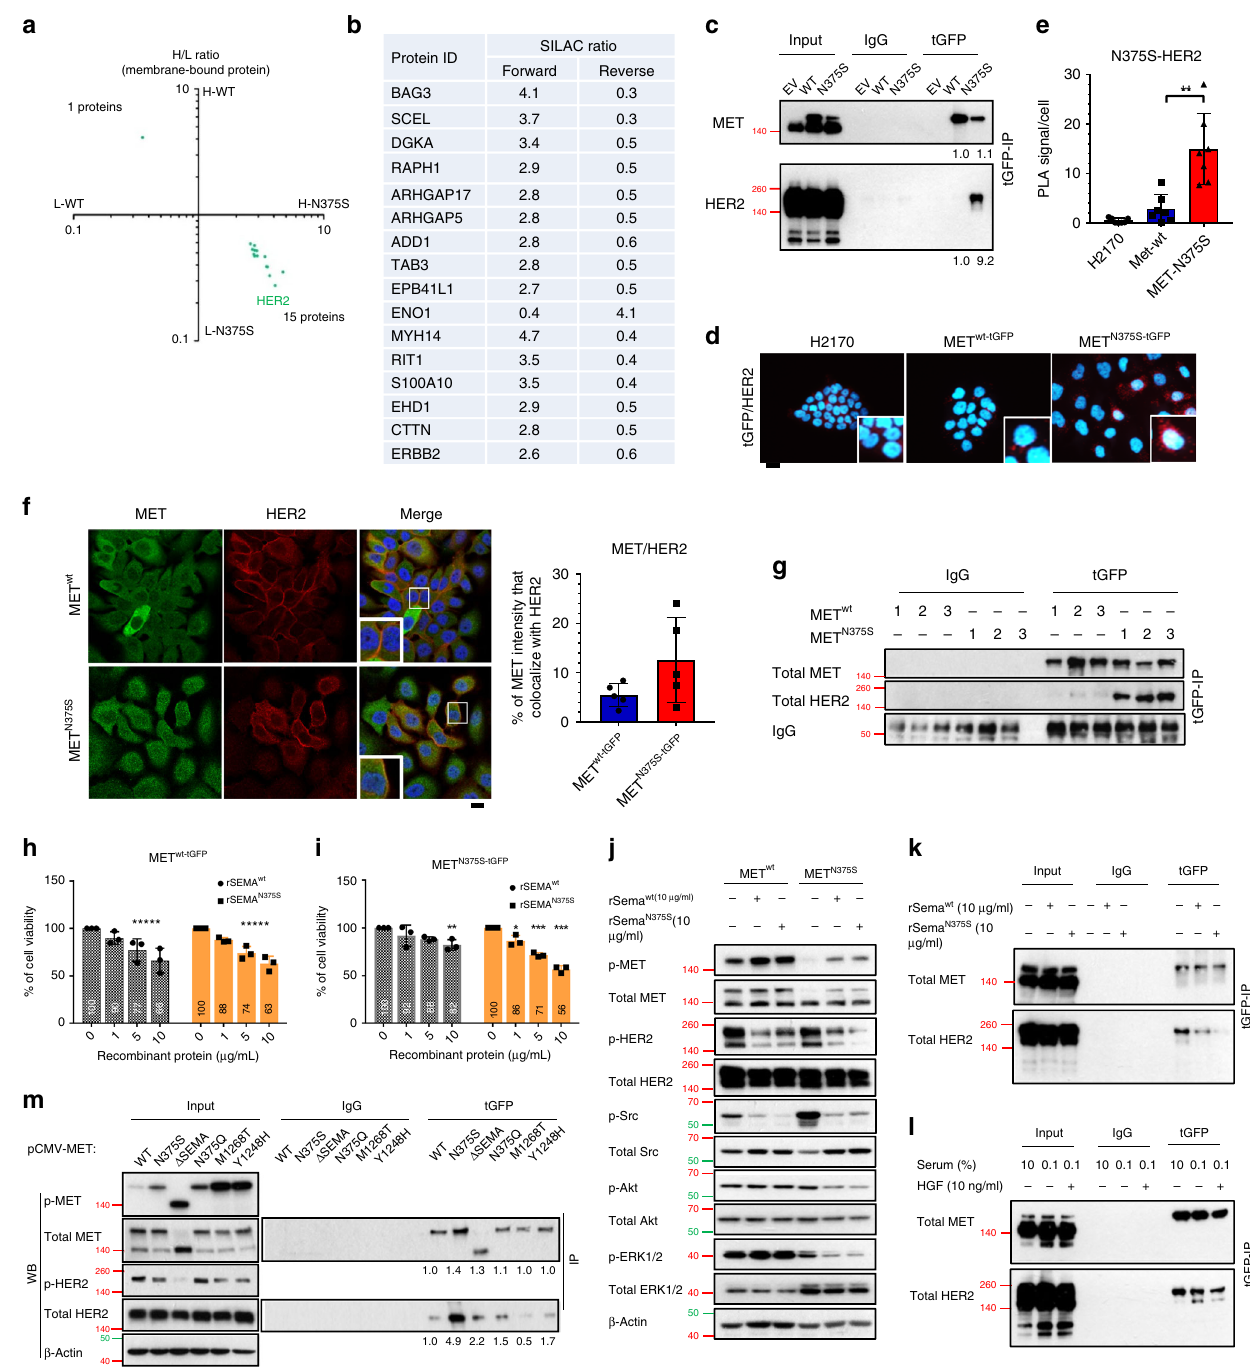
normalized SILAC ratio above 2.5 (in both “ forward ” and “ reverse ” experiments where the labels were switched) were selected for validation (Fig. 4a, b); and among these, only HER2 strongly co-immunoprecipitated with exogenous MET N375S (Fig. 4c; Supplementary Fig. 5A). This preferential interaction was further substantiated with in situ proximity ligation assay (PLA) and fl uorescent confocal imaging, that con fi rmed the proximal co-localization and possible heterodi- merization of MET N375S and HER2 (Fig. 4d – f). We further demonstrated the speci fi city of this receptor dimerization by con fi rming the lack of receptor-binding preference of MET N375S to other TKs, such as EGFR and Src (Supplementary Fig.